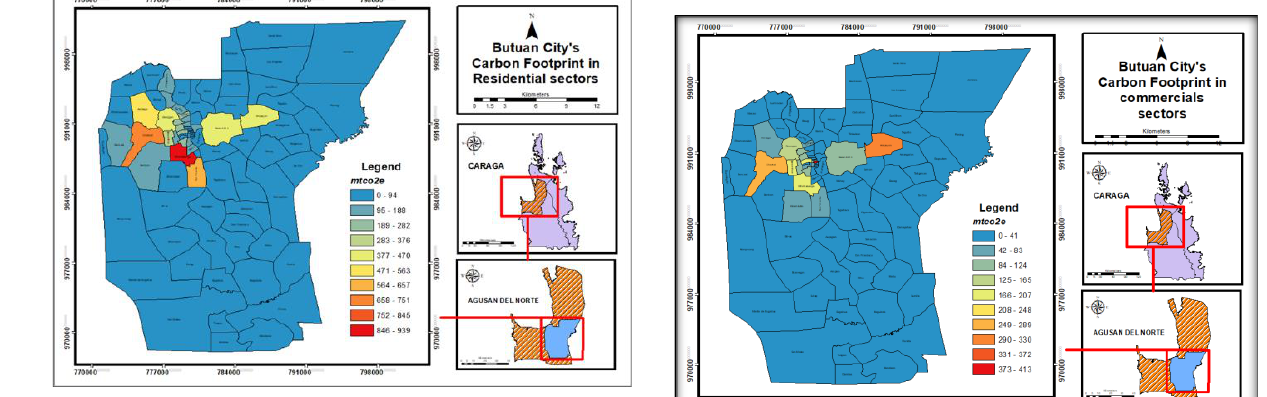
Figure 9. Spatial distribution of carbon footprint from residential electricity consumption during COVID-19